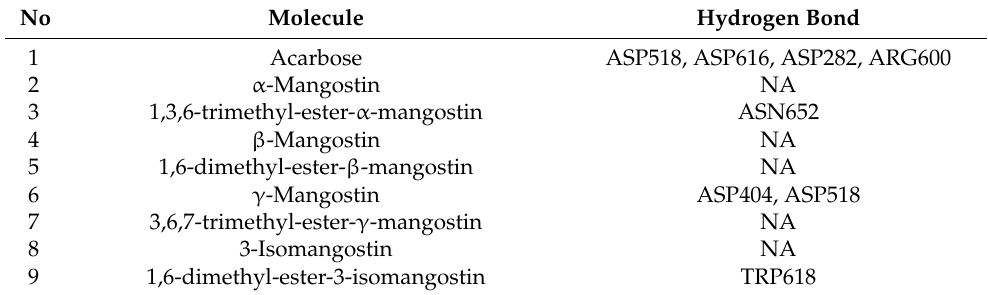
Table 5. Intermolecular hydrogen bonds are formed between α -glucosidase and its ligands.